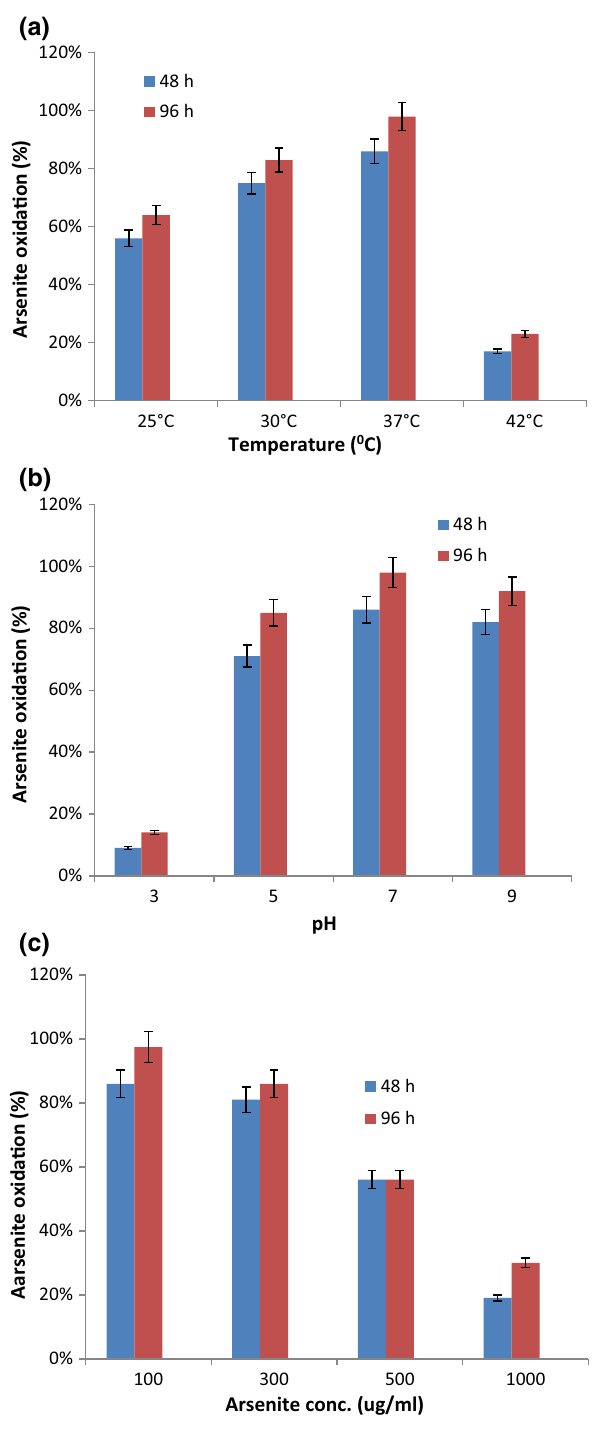
Fig. 3 Arsenite oxidation potential of B. licheniformis A6 at tempera- ture ( a ), pH ( b ) and arsenite concentration ( c